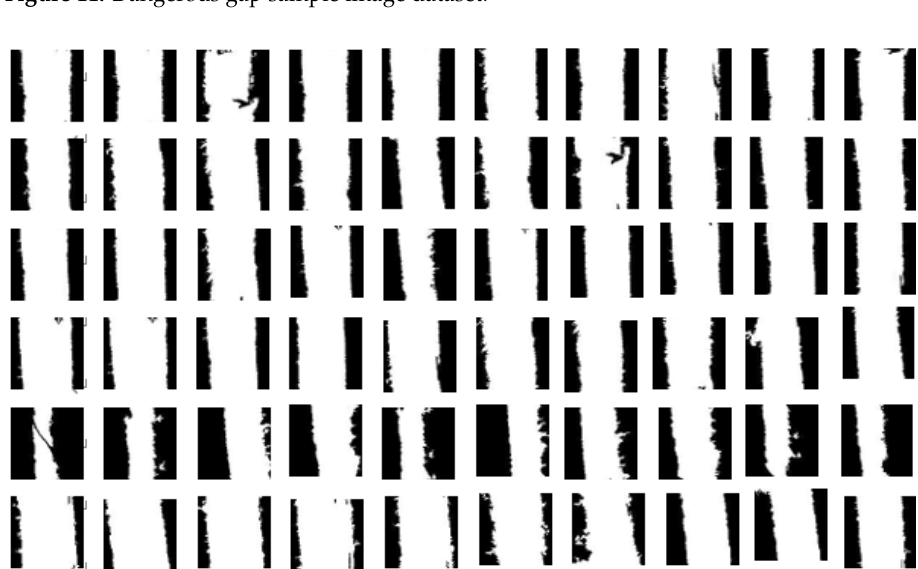
Figure 12. Non-dangerous gap sample image dataset.